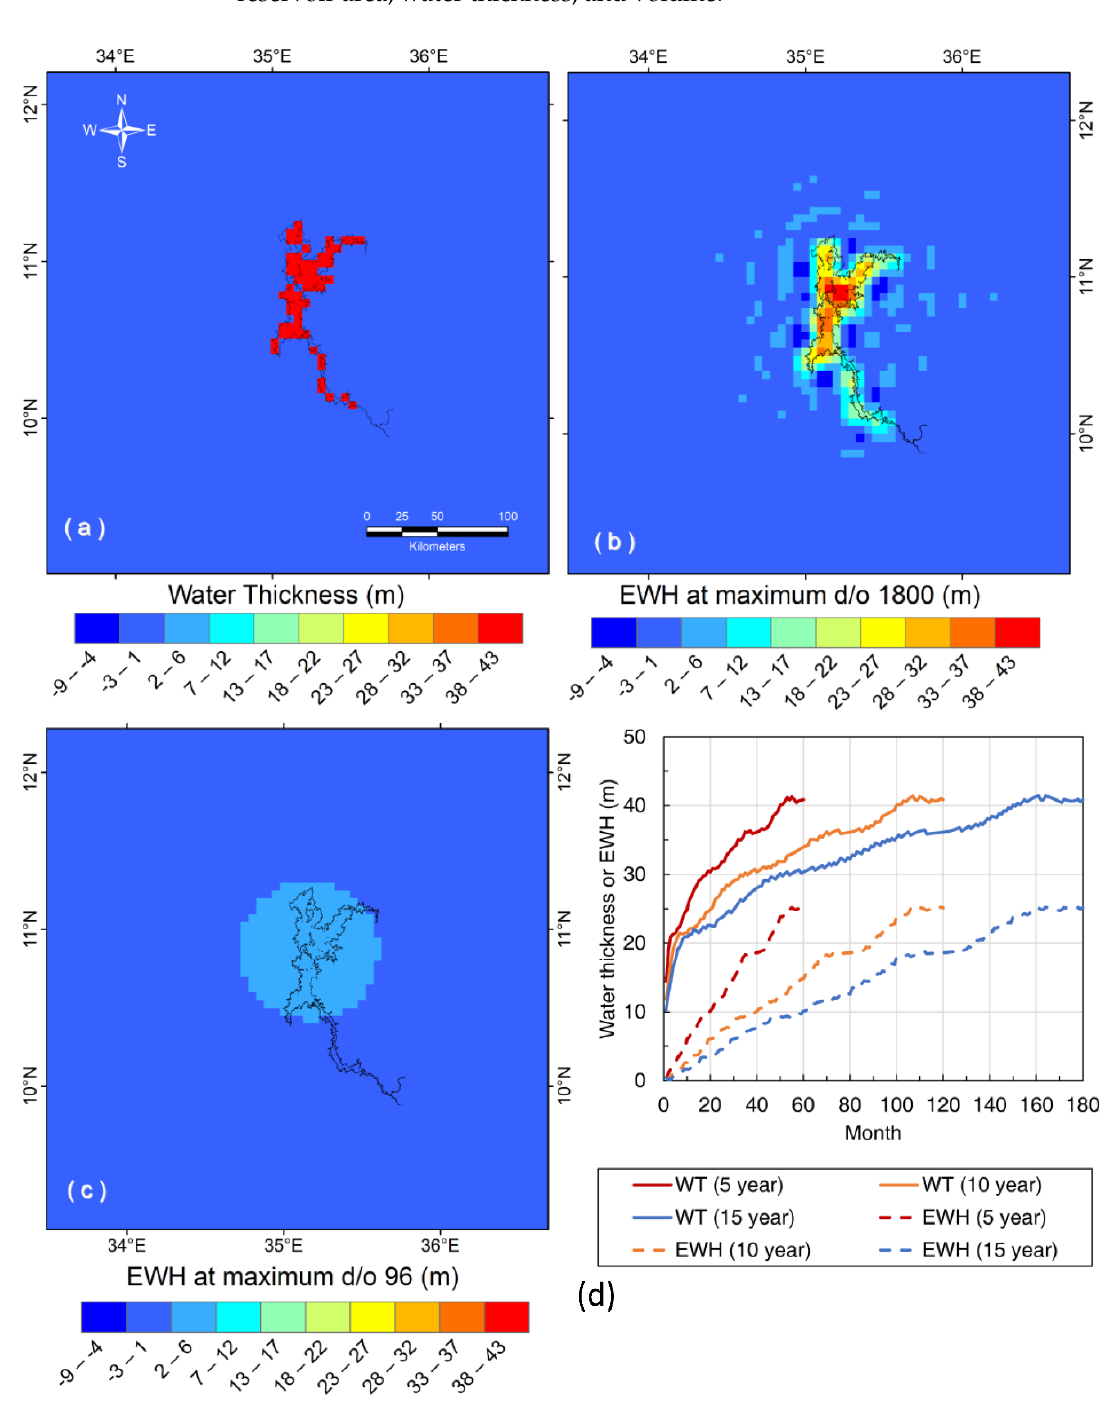
Figure 5. Water thickness and equivalent water height (EWH) for the last month (water thickness: 41 m; area: 1689 km 2 ; volume: 70 km 3 ): ( a ) Water thickness with a constant value of 41 m inside the GERD reservoir and 0 outside; ( b , c ) EWH estimates from SHC truncated to a maximum degree/order of 1800 and 96, respectively; and ( d ) temporal variations of water thickness (WT) and EWH for different filling strategies (5, 10, and 15 years).